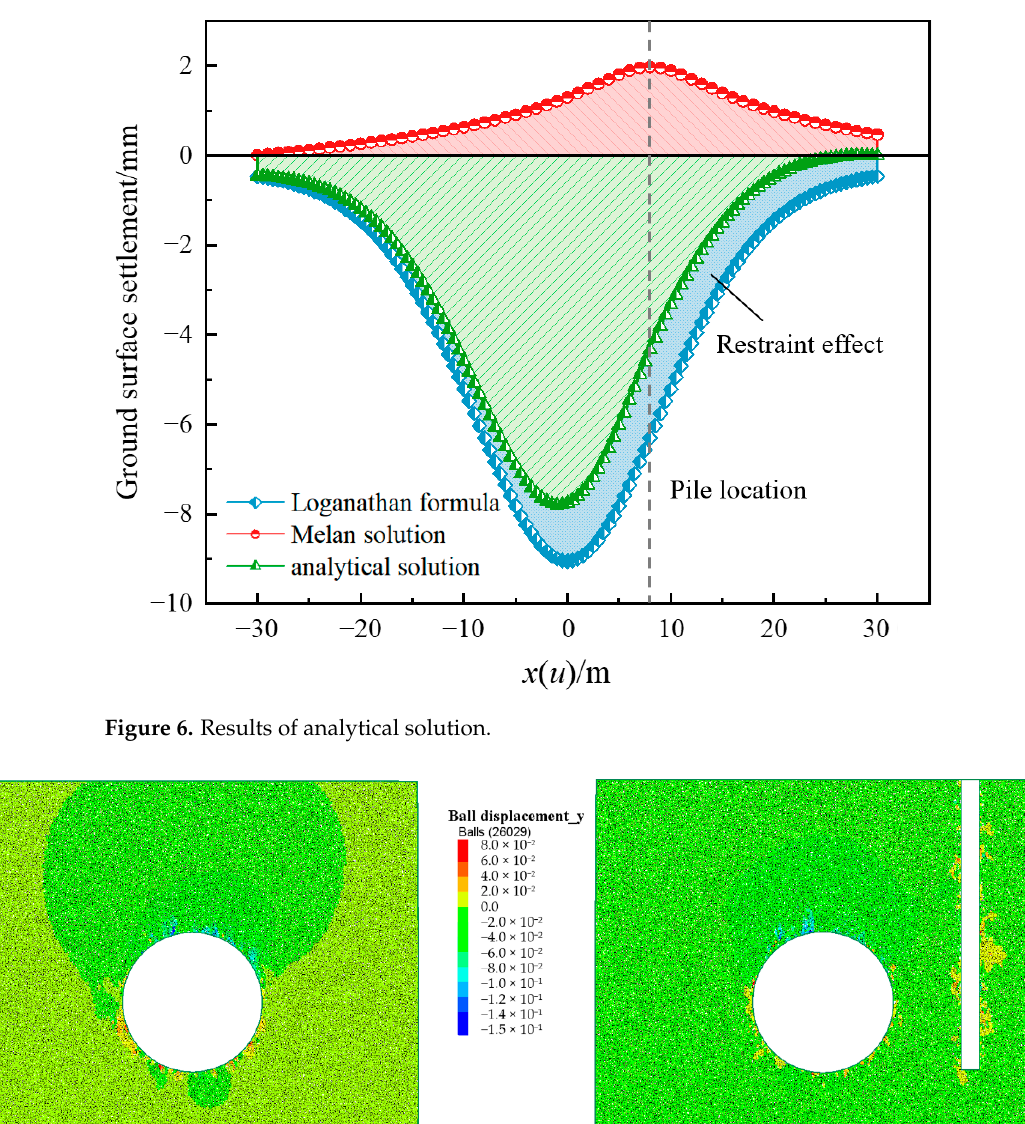
The comparisons of surface settlement trough calculated by FDM-DEM coupling